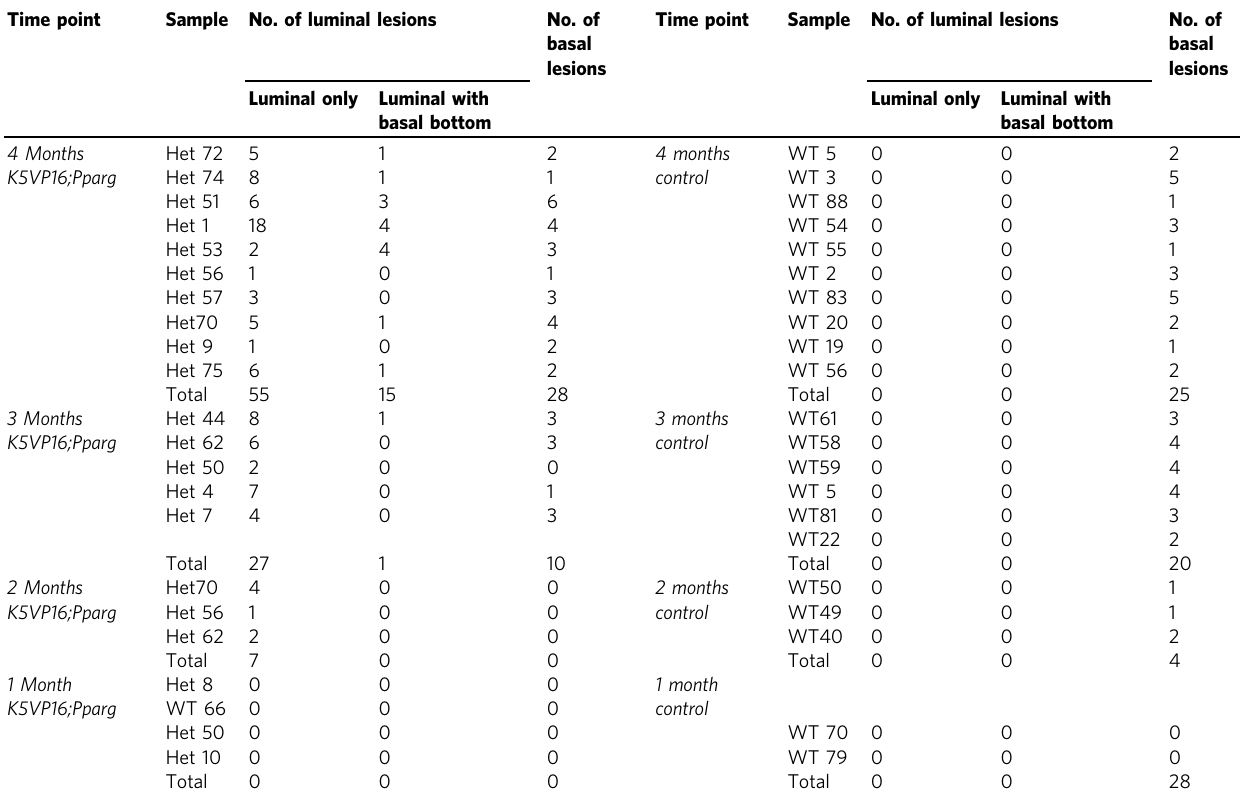
Table 1 Quanti fi cation of tumor class in VP16;Pparg controls and K5VP16;Pparg mutants. Time point Sample No. of luminal lesions No. of